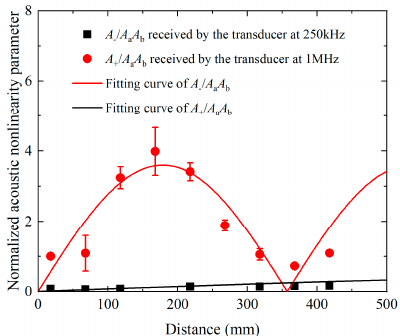
Figure 14. For the nonlinear mixing of S 0 modes at 400 kHz and 600 kHz, normalized acoustic non- linearity parameters of A − or A + and their fitting curve versus propagation distance, measured by the receivers with central frequencies of 250 kHz and 1 MHz respectively.